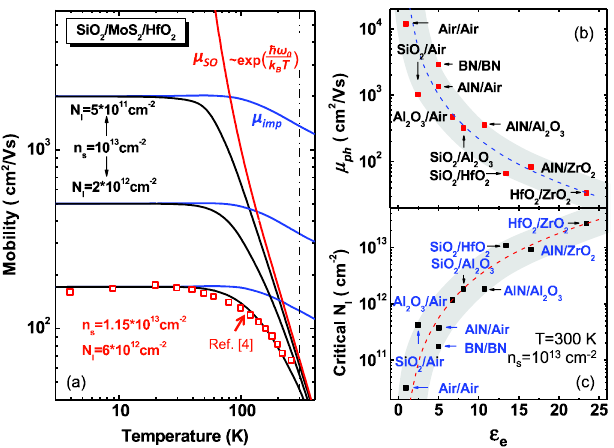
FIG. 6. (a) Temperature-dependent electron mobility (black lines) in SiO 2 = MoS 2 = HfO 2 structure. The blue lines indicate μ imp and the red lines show μ . Open squares show experimental SO results from single-layer MoS 2 FETs from Ref. [4]. (b) Room- temperature phonon-determined electron mobilities μ and ph ¼ (c) the critical impurity densities N corresponding to μ cr imp μ in SL MoS 2 surrounded by different dielectrics. Dashed lines ph show the fitted μ and N ph cr